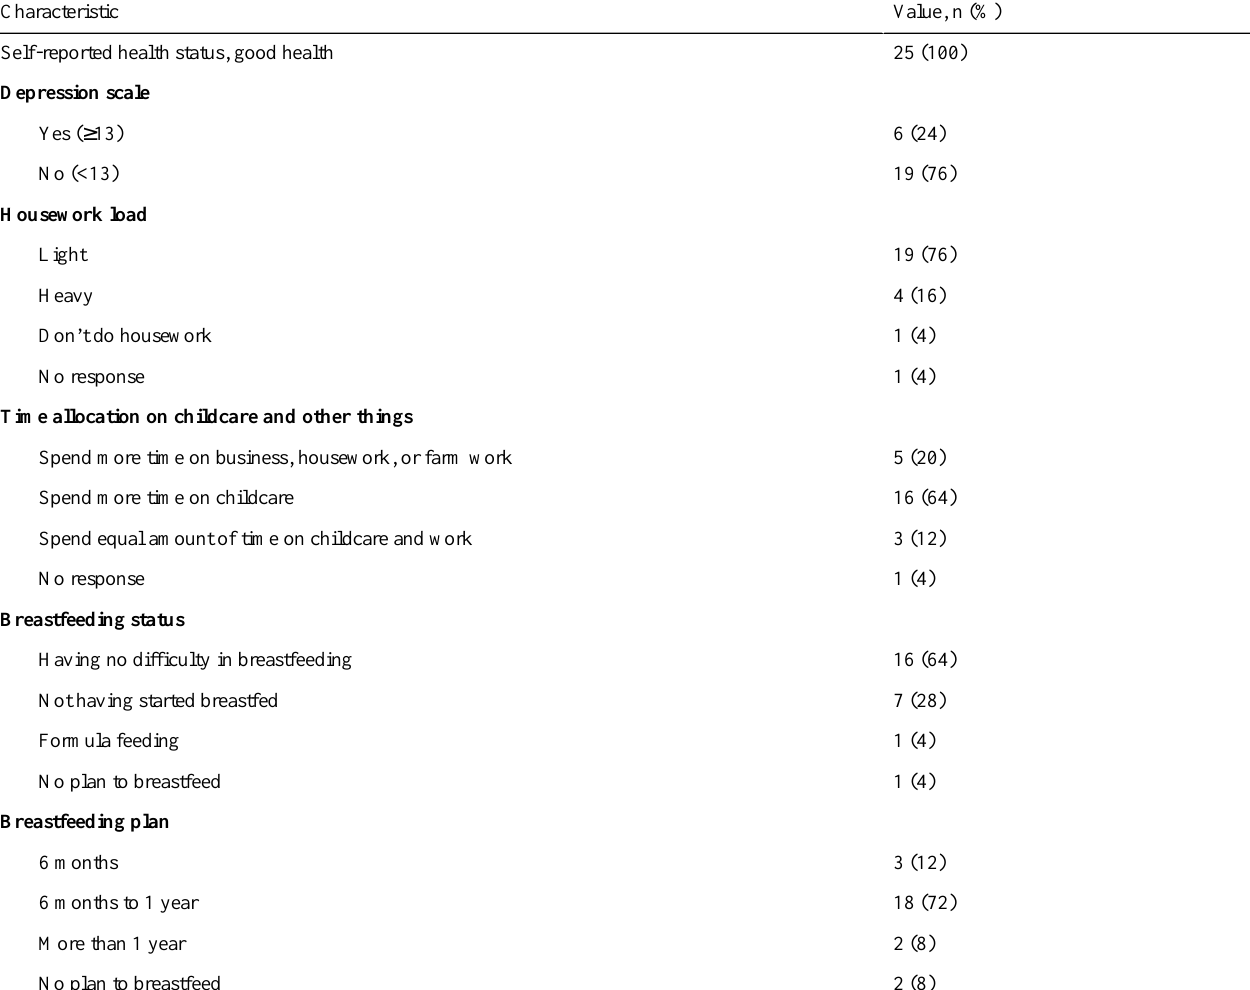
Table 2. Mothers’health, work, and breastfeeding behavior (n=25).